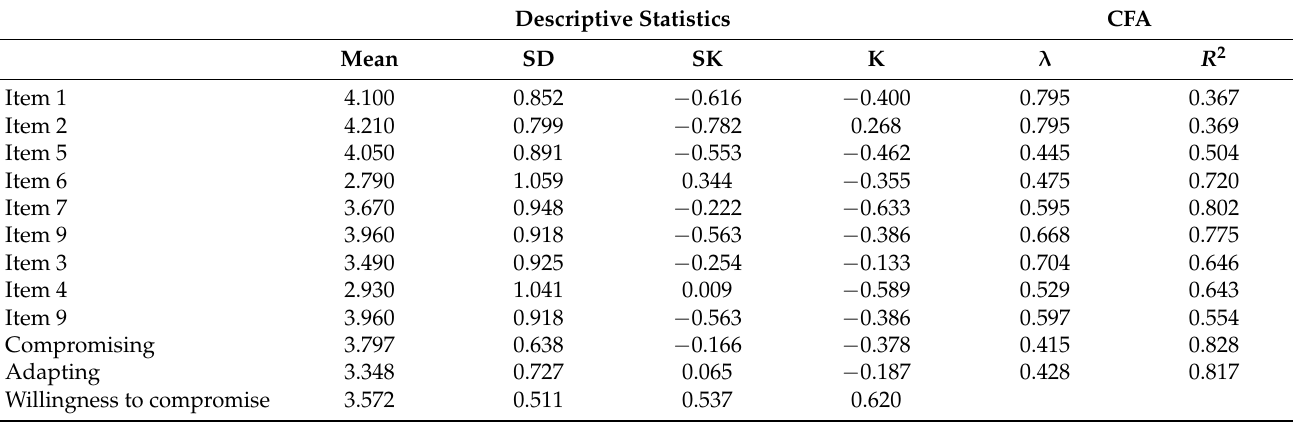
Table 1. Item descriptive statistics and confirmatory factor